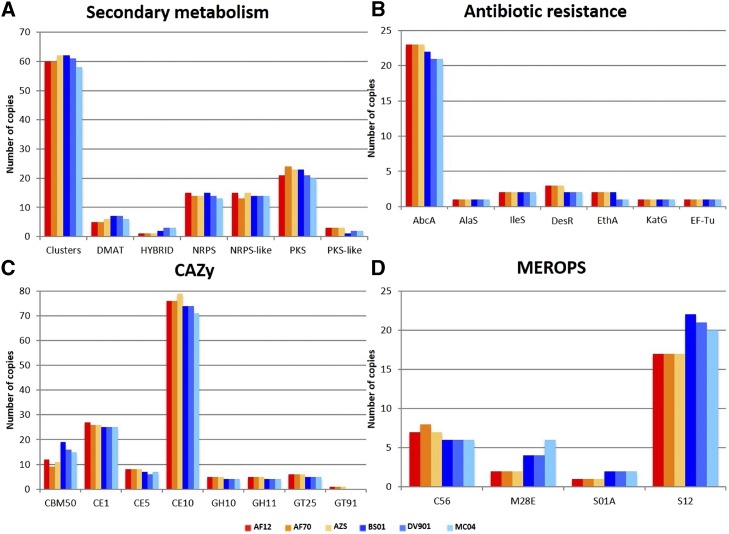
Differences in copy numbers of proteins involved in secondary metabolism, antibiotic resistance, carbohydrate metabolism, and peptidase activity between S and L morphotype genomes. (A) Number of secondary metabolite clusters and their backbone genes predicted in each genome by SMURF (Khaldi et al., 2010). Abbreviations: prenyltransferases (DMAT), nonribosomal peptide synthase (NRPS), polyketide synthase (PKS), hybrid NRPS-PKS enzymes (HYBRID). (B) Number of proteins predicted to confer antibiotic resistance in each genome by CARD (Jia et al., 2017). Abbreviations: multidrug resistant ABC transporter (AbcA), aminocoumarin resistant (AlaS), Bifidobacteria intrinsic ileS conferring resistance to mupirocin (IleS), β-Glycosidase involved in Streptomyces venezuelae self-resistance (DesR), Mycobacterium tuberculosis ethA with mutation conferring resistance to ethionamide (EthA), M. tuberculosis katG mutations conferring resistance to isoniazid KatG, S. cinnamoneus elongation factor thermo unstable mutants conferring resistance to elfamycin (EF-Tu). (C) CAZy categories (Yin et al., 2012) with differences in copy numbers between S and L morphotype genomes. Abbreviations: carbohydrate-binding modules (CBM), carbohydrate esterases (CE), glycoside hydrolases (GH), glycosyltransferases (GT). (D) MEROPS categories (Rawlings et al., 2012) with differences in copy numbers between S and L morphotype genomes. Abbreviations: PfpI endopeptidase family/cysteine peptidase (C56), aminopeptidase Y family/metallo peptidase (M28), chymostrypsin family/serine peptidase (S01), D-Ala-D-Ala carboxypeptidase B family/serine peptidase (S12).